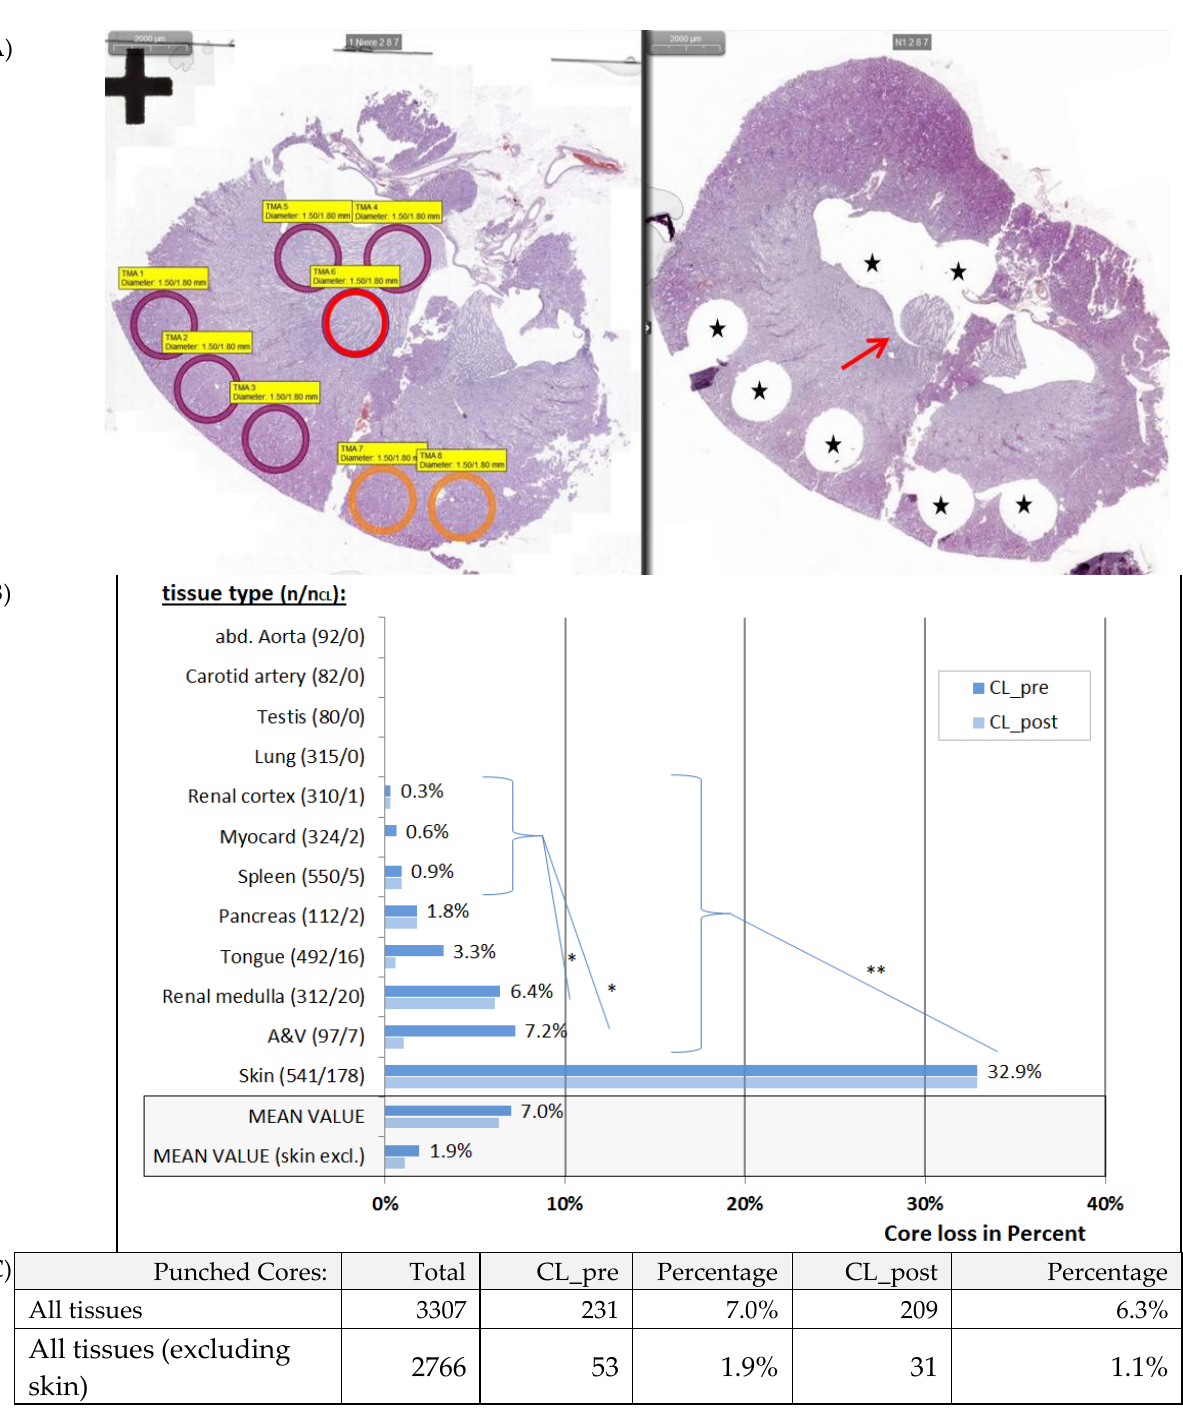
Figure 3. Correlation of core Loss and tissue type. ( A ) H&E slide of a donor block on the left side before and on the right side after the punching procedure. Punched areas (*) and one core loss (arrow) on a renal specimen. ( B ) Core loss is shown in correlation to the different tissue types in percent. CL_pre shows the core loss before and CL_post the core loss after manual replacement of dispatched tissue cores. There is a strong significance ( p < 0.001, Chi-Square), indicated with **, when comparing skin tissue to the other tissues and a significant difference ( p < 0.01), indicated with *, when comparing the Renal medulla and A&V-tissue with the renal cortex, myocard and spleen tissues. ( C ) The table contains the total number and the percentage of core loss.